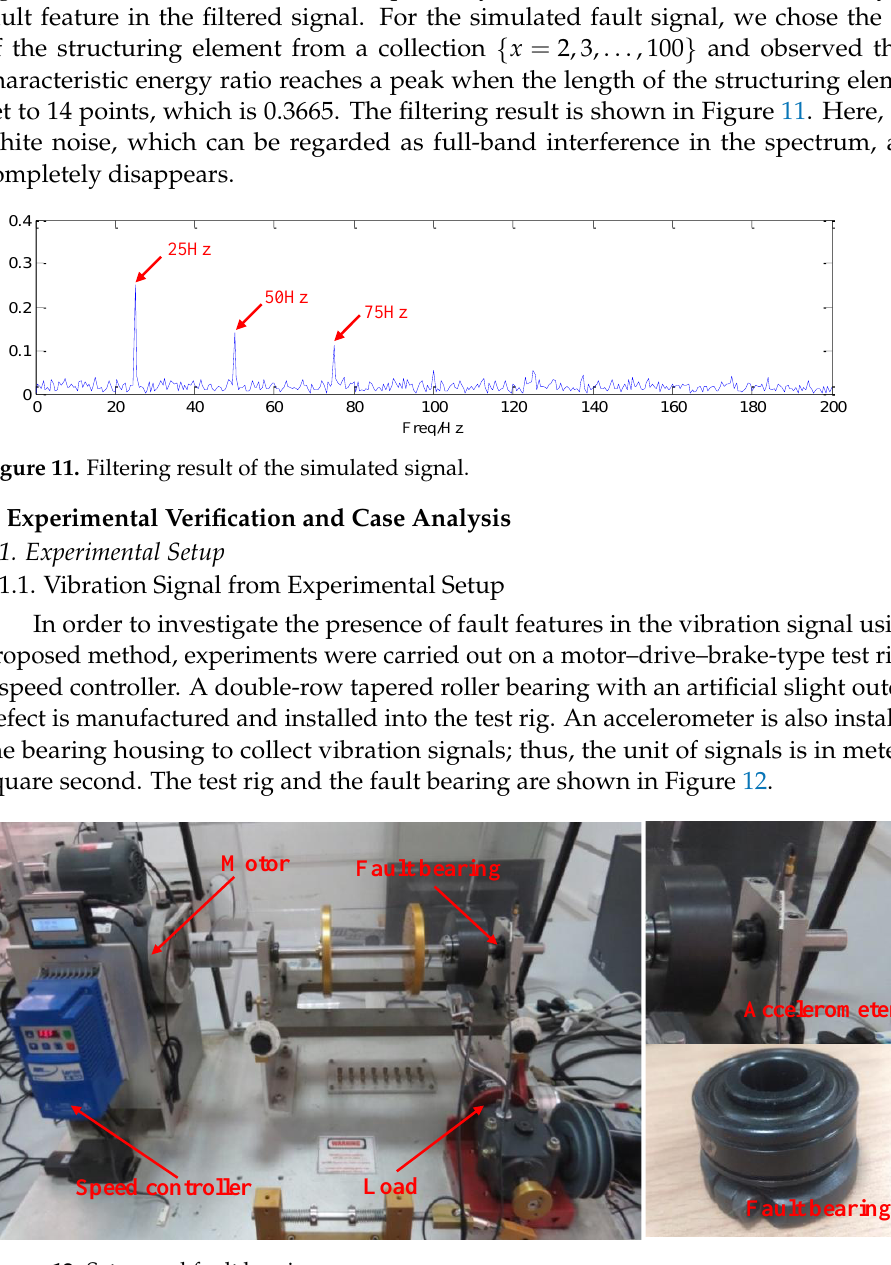
Table 1. Characteristic frequency of fault bearing. Outer Race